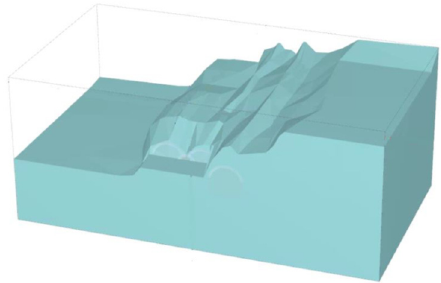
Figure 17. Schematic diagram of the analysis mode under biased pressure.